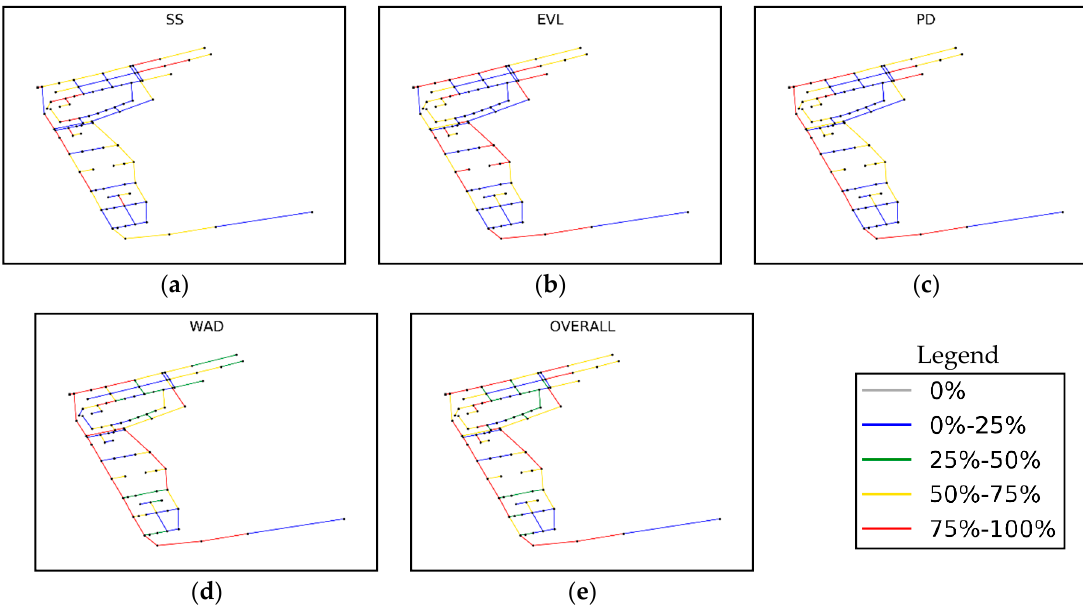
Figure 4. Critical pipe assessment for ( a ) supply shortage ( SS) , ( b ) economic value loss ( EVL) , ( c ) pressure decline ( PD) , ( d ) water age degradation ( WAD) , and ( e ) OVERALL of Network 2.